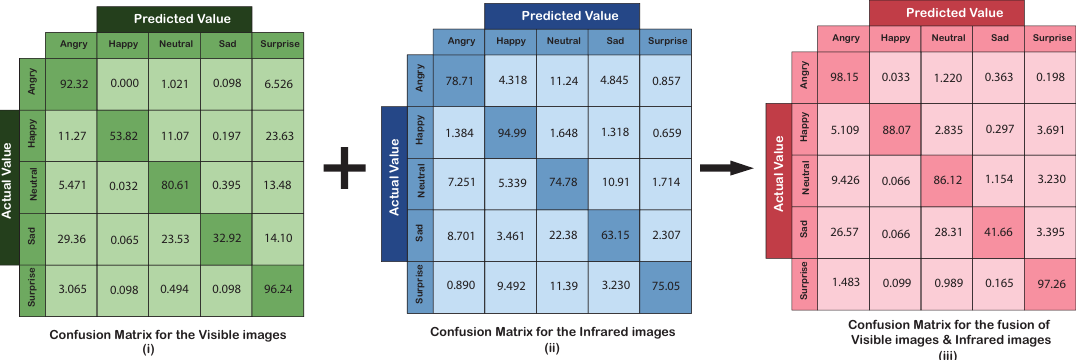
Figure 6. Confusion matrix for the visible images, infrared images, and fusion of images.